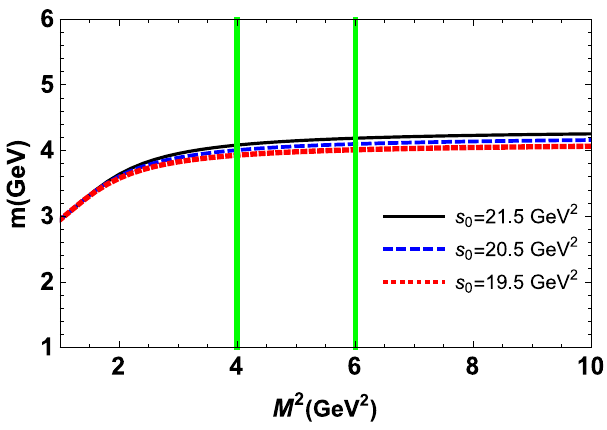
as a function of the Borel parameter M 2 at fixed cc